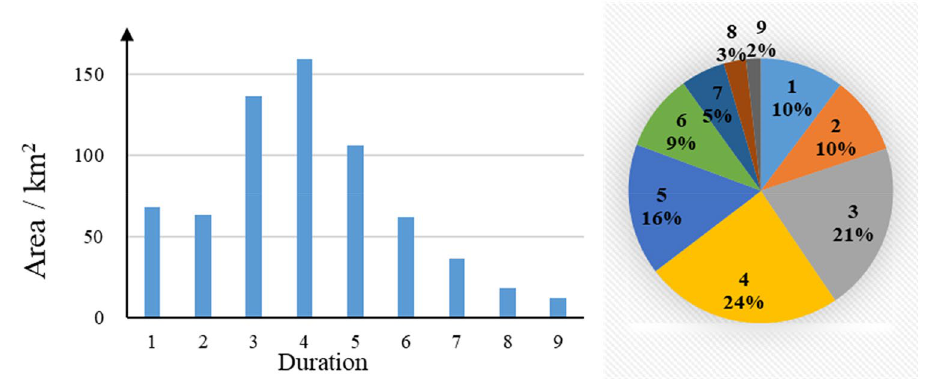
Figure 4. Area of the duration of disturbance of the urban built-up area